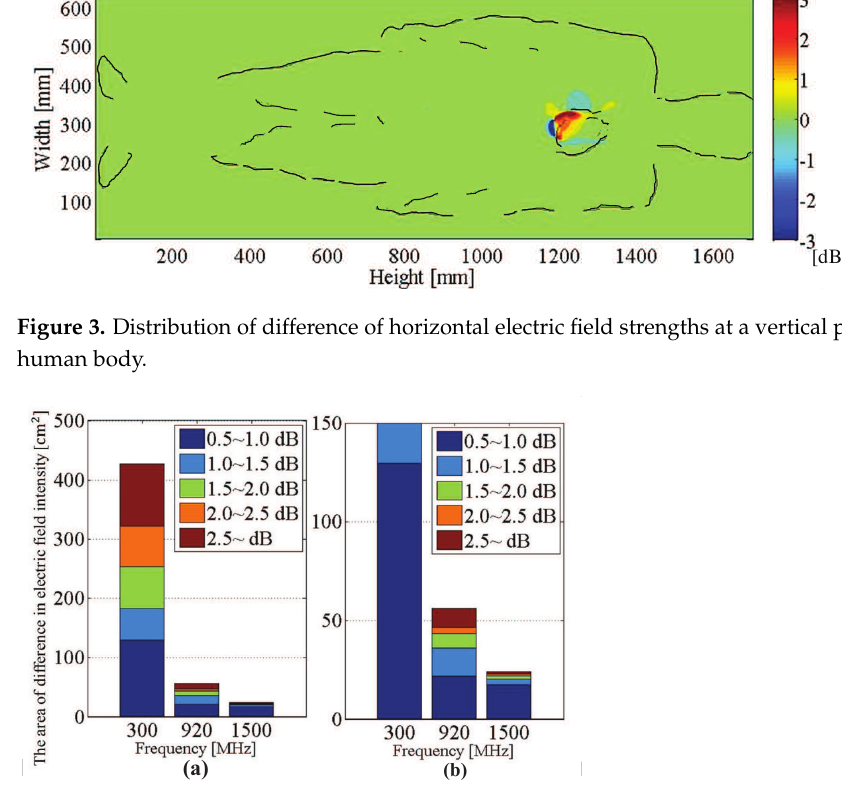
Figure 4. ( a ) Area of change of horizontal electric field strength behind the human body for the diastolic model and the systolic model. ( b ) An enlargement of ( a